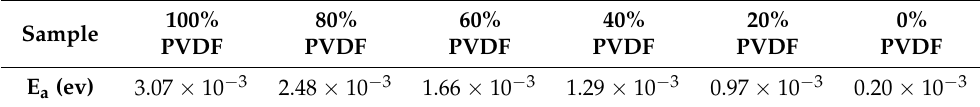
Table 1. Values of activation energy of (BZT-PVDF) composite.